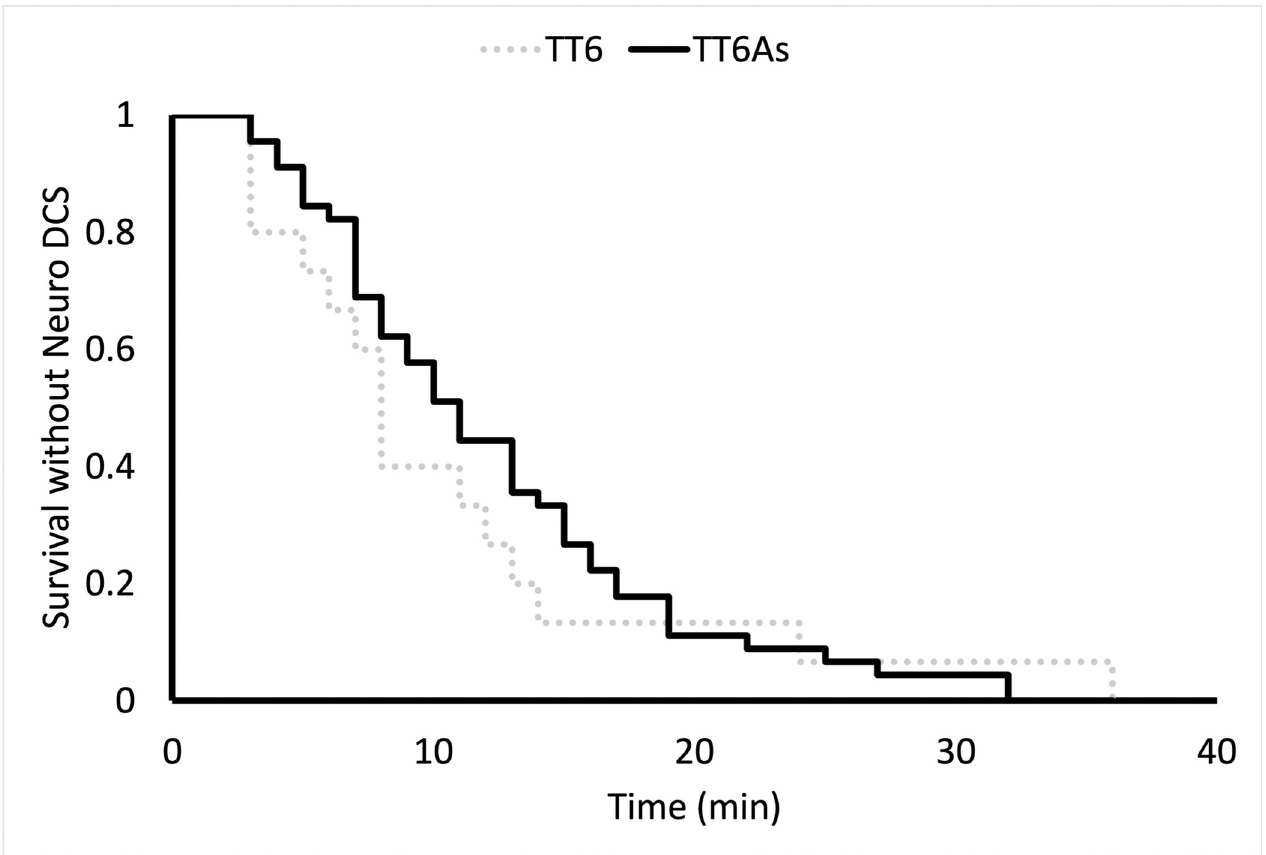
Fig 6. (A) Histogram showing incidence of spinal cord lesion across all animals included in the pathology analysis (55). (B) Histogram showing the mean spinal cord lesion area across all animals included in the pathology analysis.